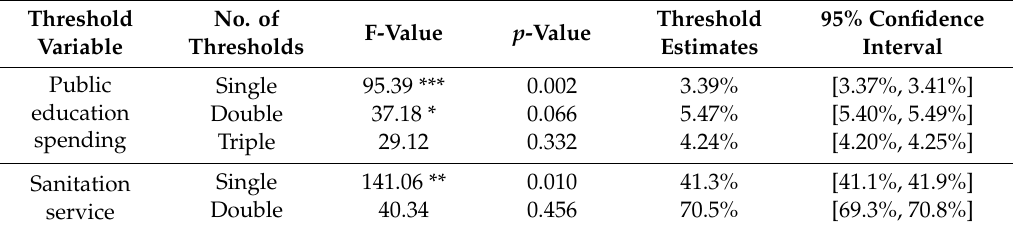
Table 9. Tests for threshold e ff ects between fine particulate air pollution and